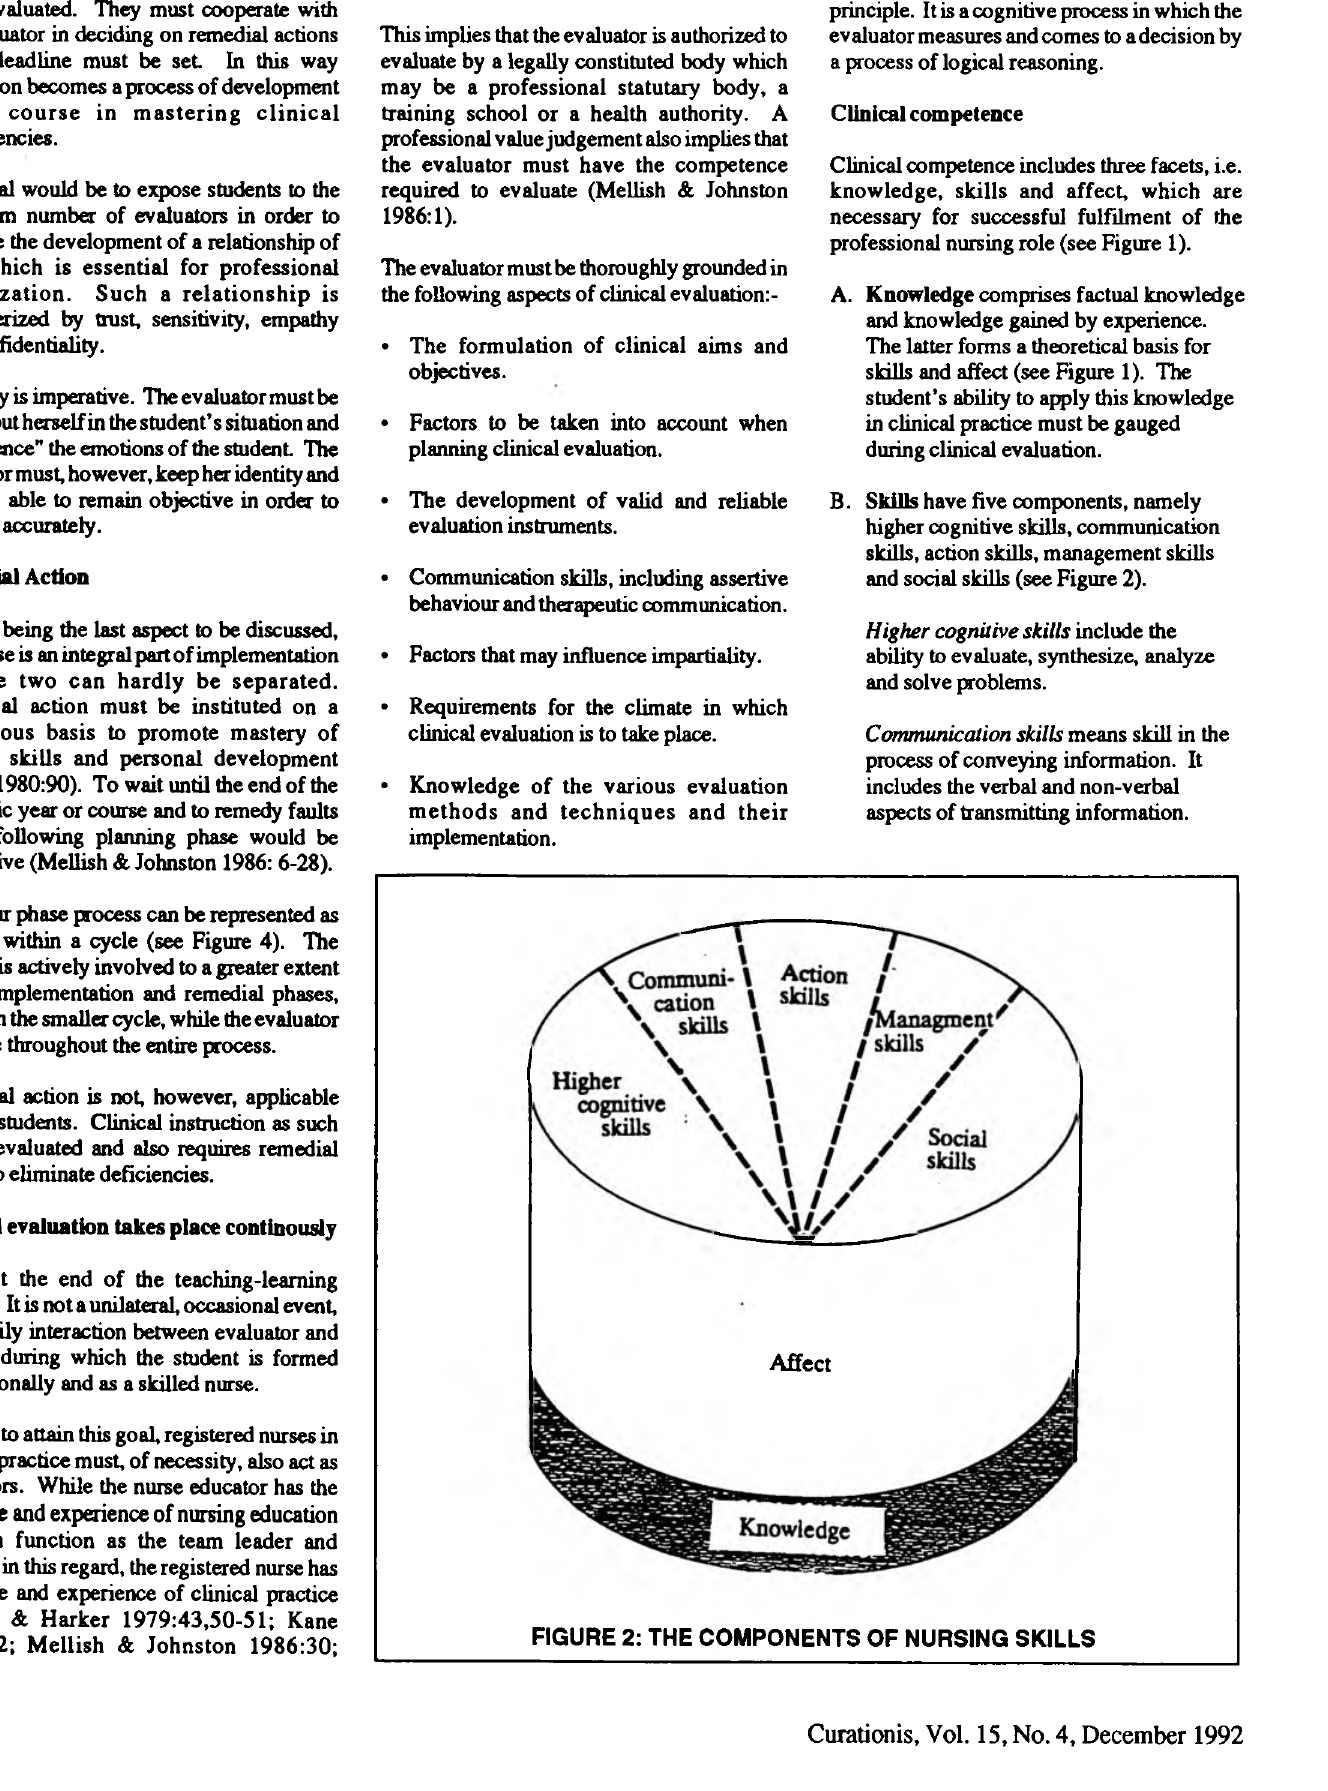
FIGURE 2: THE COMPONENTS OF NURSING